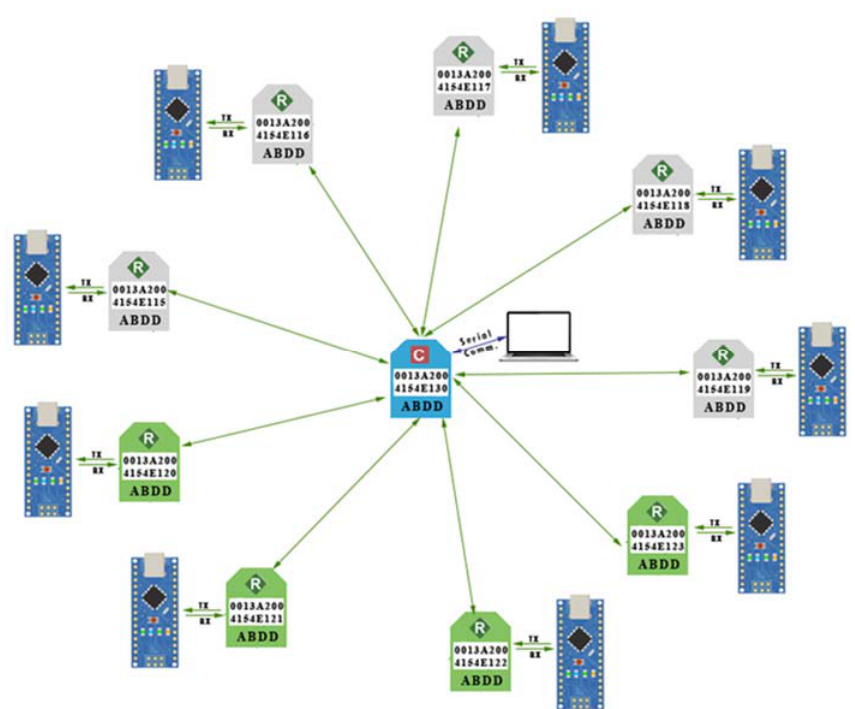
Figure 1. System Figure 1. System configuration.